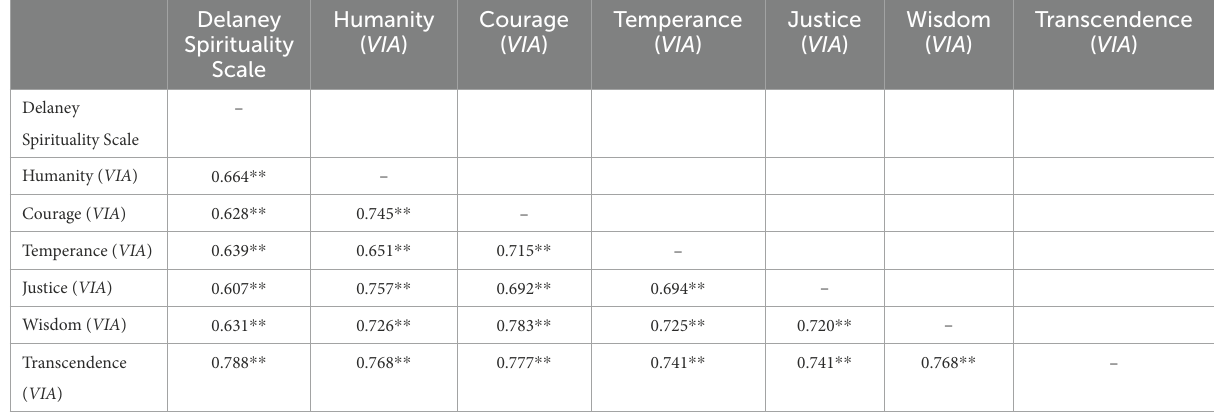
TABLE 2 Pearson correlation among participant scores on the DSS and the VIA